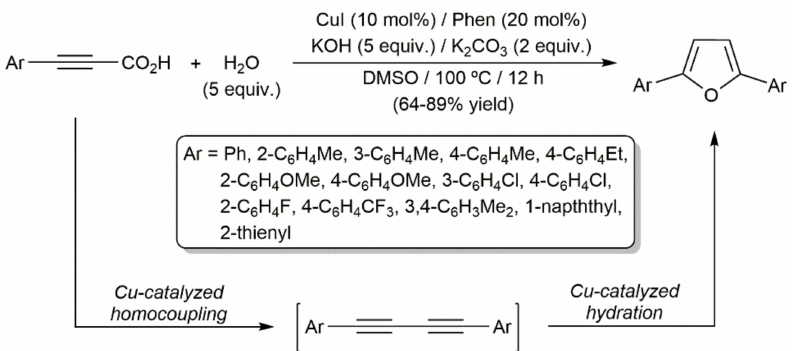
Scheme 56. Copper-catalyzed synthesis of 2,5-disubstituted furans from propiolic